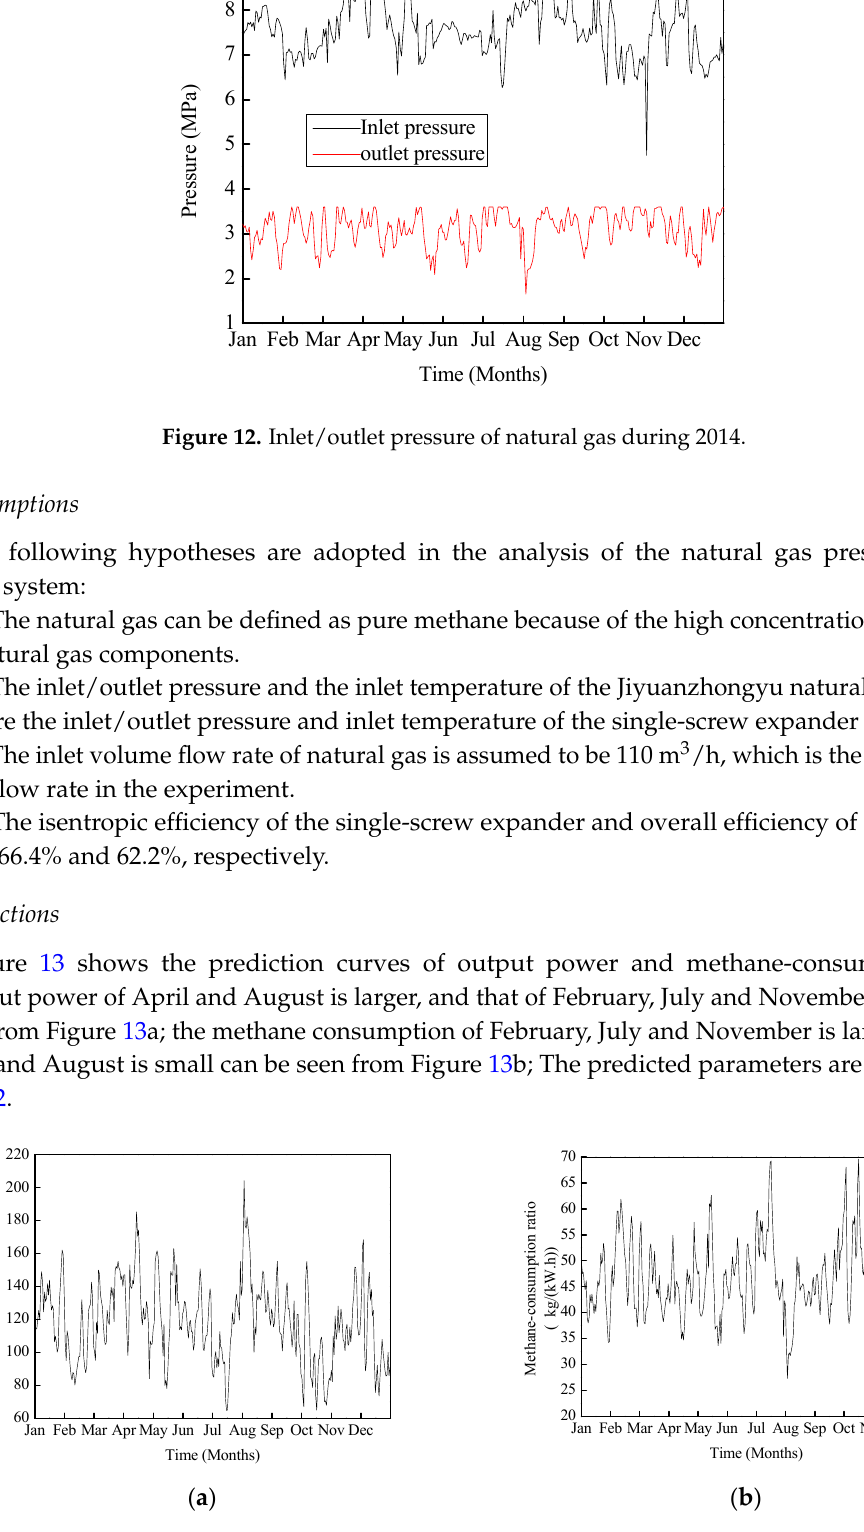
Figure 13. Predicted parametric curves of output power ( a ) and methane-consumption ratio ( b ). Table 2. Predicted results summary.